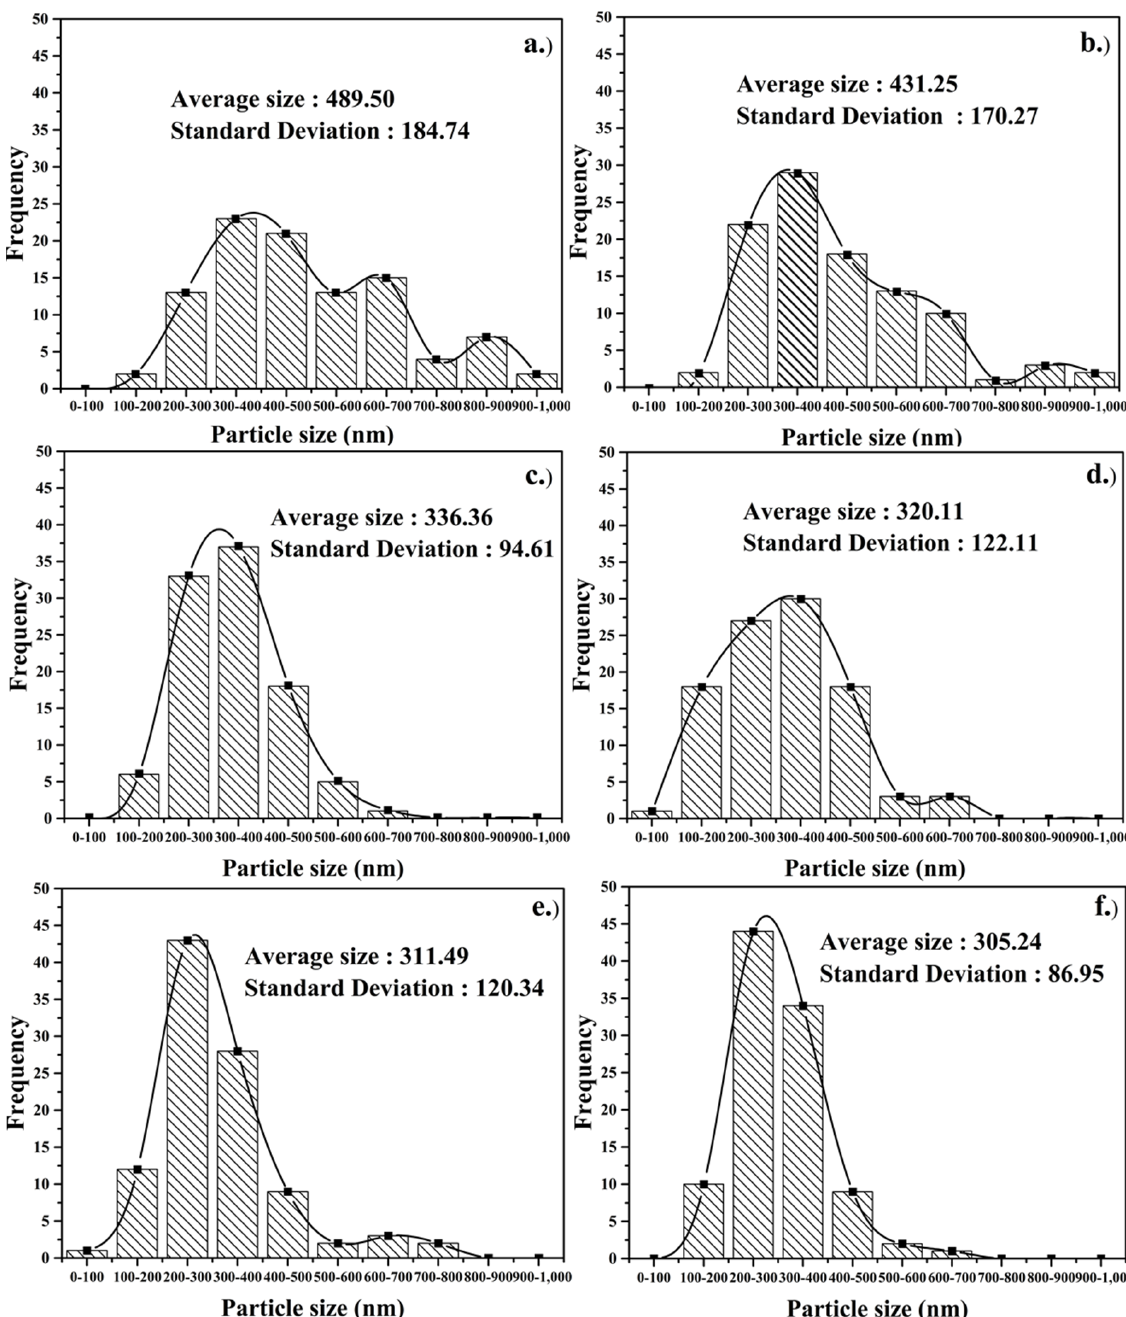
Figure 5. Particle size analysis of biphasic calcium phosphate prepared by cuttlebone with variation of the CMC of L-rhamnose monohydrate biosurfactant: ( a ) no CMC, ( b ) 10 CMC, ( c ) 20 CMC, ( d ) 100 CMC, ( e ) 500 CMC and ( f ) 1000 CMC. The formula for average size and SD is also